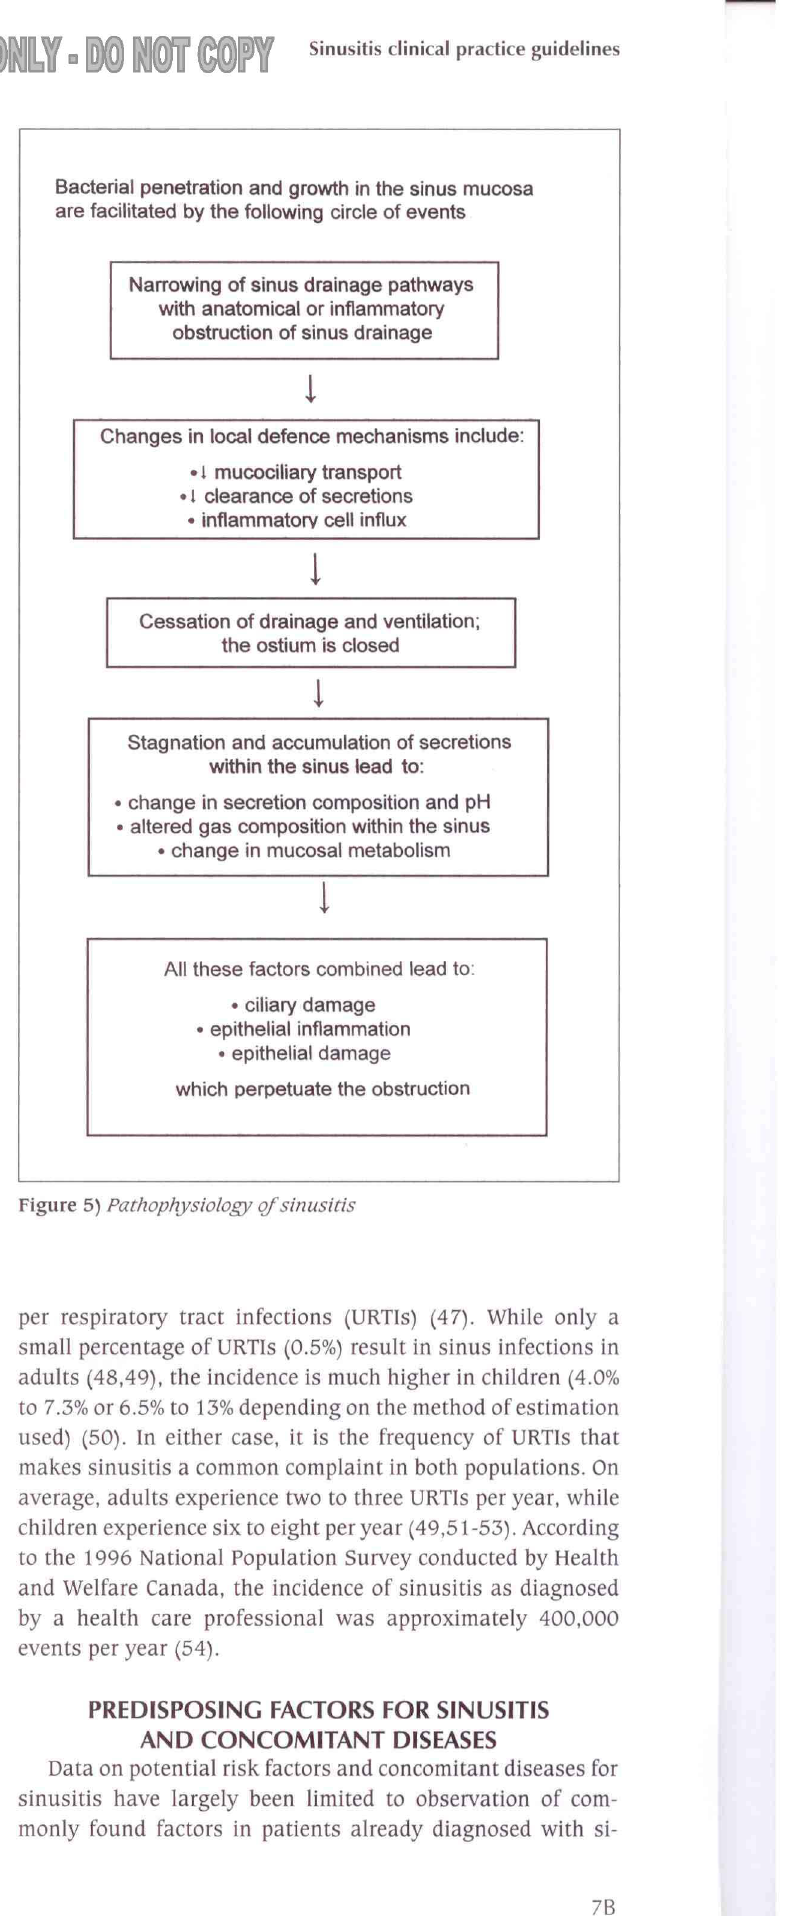
per respiratory tract infections (URTis) (47). While only a small percentage of URTis (0.5%) result in sinus infections in adults (48,49), the incidence is much higher in children (4.0% to 7.3% or 6.5% to 13% depending on the method of estimation used) (50). In either case, it is the frequency of URTis that makes sinusitis a common complaint in both populations. On average, adults experience two to three URTis per year, while children experience six to eight per year (49,51-53).